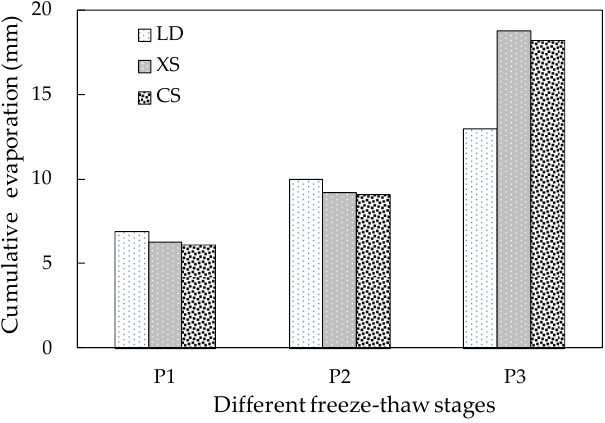
Figure 4. Soil evaporation under different sand mulches in the different freeze – thaw stages.